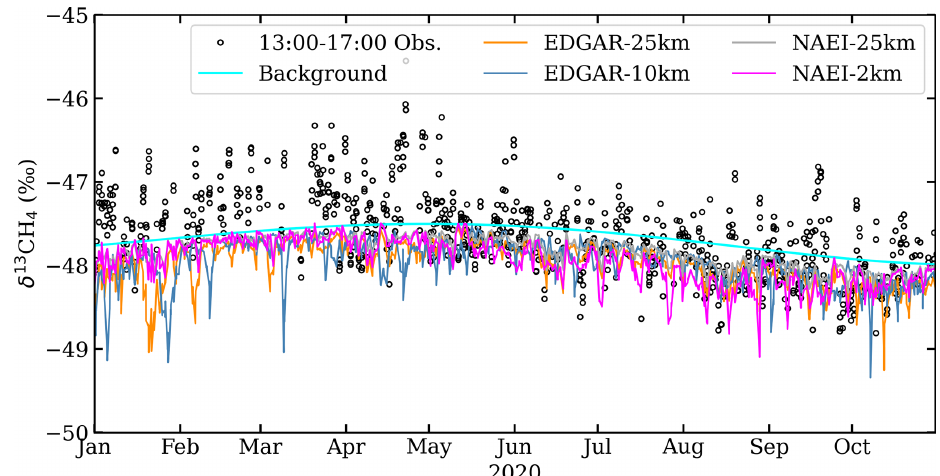
Figure 11. Simulated and measured δ 13 CH 4 values for 2020 using 13:00–17:00 data.